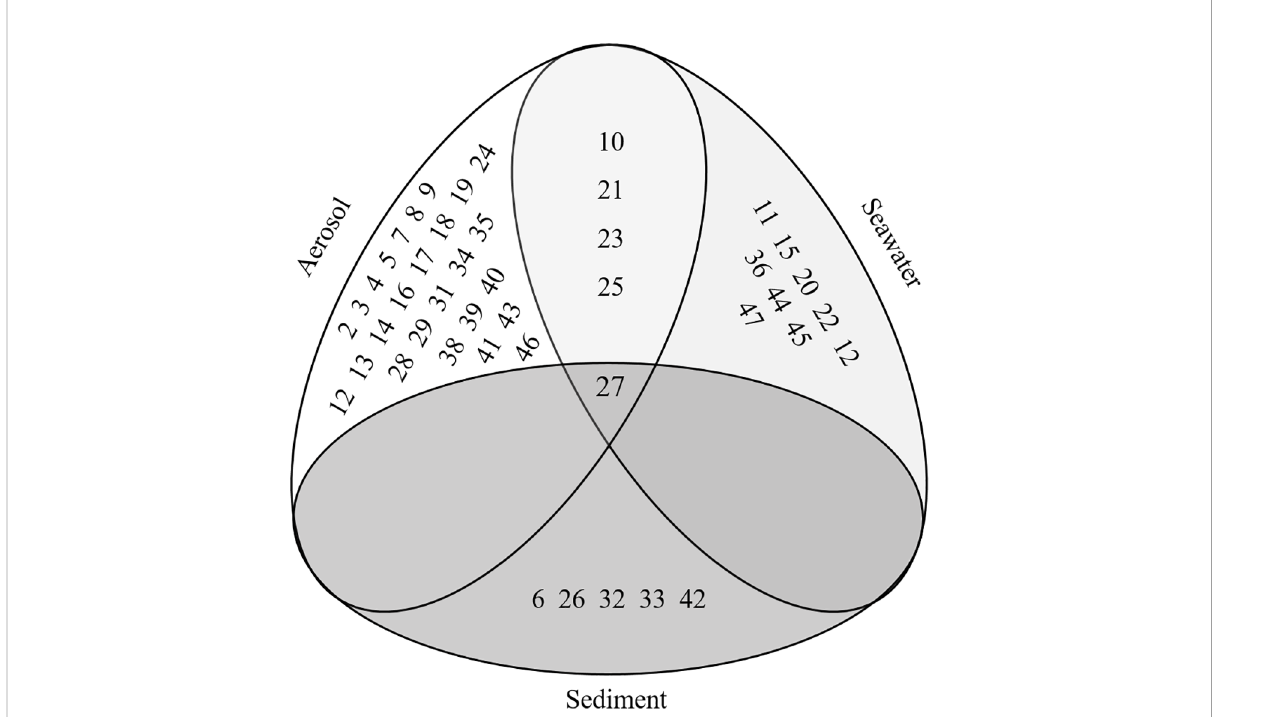
FIGURE 3 A Euler diagram illustrating the categories of microplastics identi fi ed in the air, seawater, and sediment samples, and those that overlap in two or more of the sample media. Full descriptions of the characteristics de fi ning each category of microplastics are available in Supplementary Table